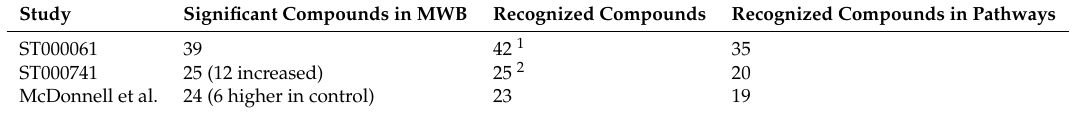
Table 1. Selection and filtering of